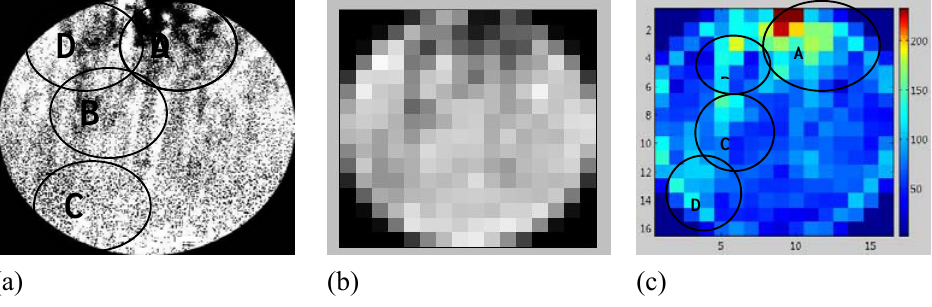
Figure 12. Image recorded by CCD Camera (a) Real Image Captured (b) Real image resized to 16 × 16 pixels with grey color (c) Real image resized to 16 × 16 pixels with color mode.